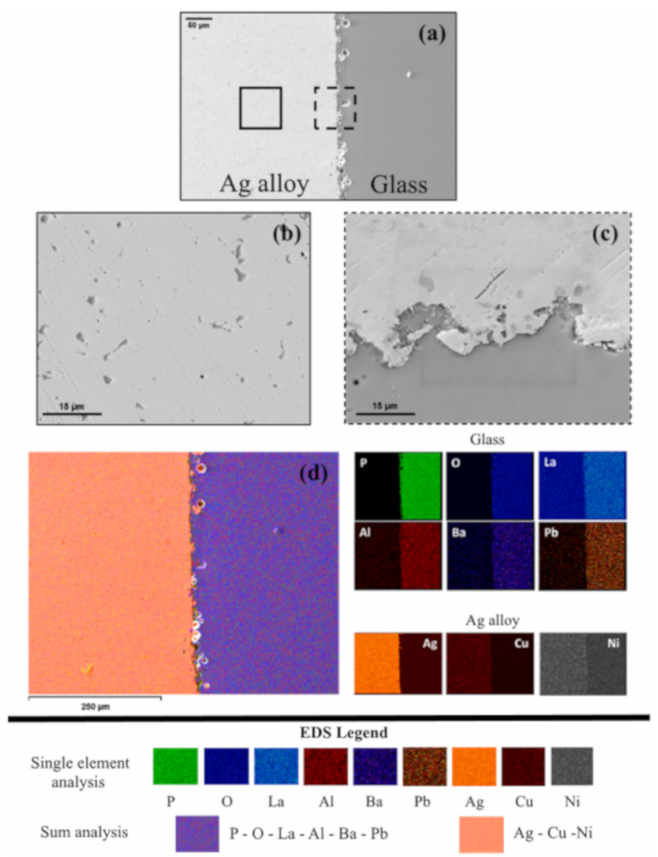
Figure 7. Cross-sectional scanning electron microscopy (SEM) images of the glass / metal interface: ( a ) metal / glass interface at low magnification, ( b ) Ag alloy, ( c ) metal / glass interface at higher magnification, and ( d ) EDS compositional map of the metal / glass